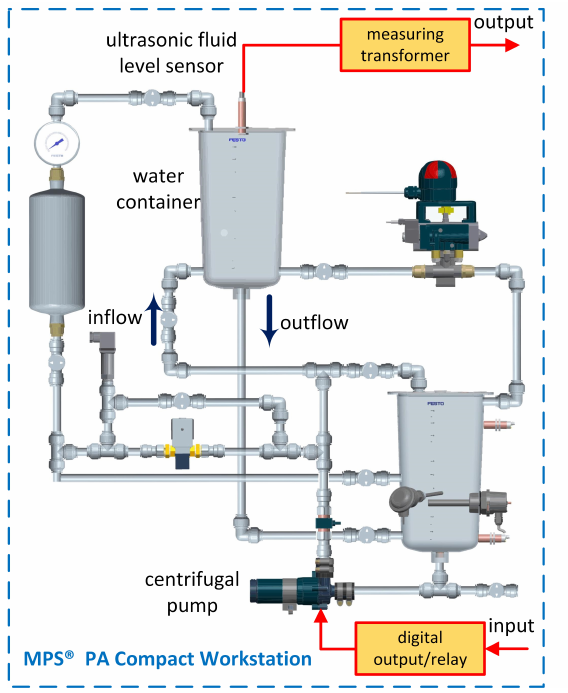
Figure 1. MPS Festo, water level control